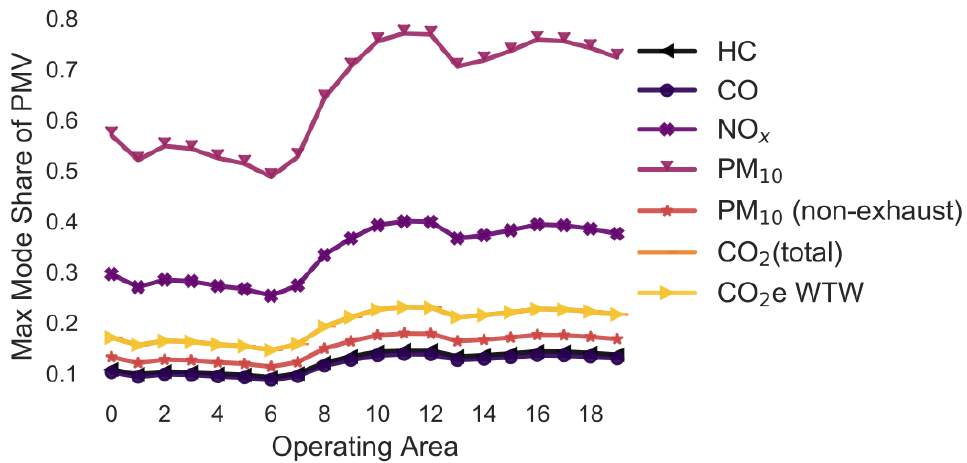
Figure 6. Maximum mode share of customers who can pick up a parcel by car (varying gradient) (note: CO 2 (total) and CO 2 e WTW are the same; HC and CO are the same).